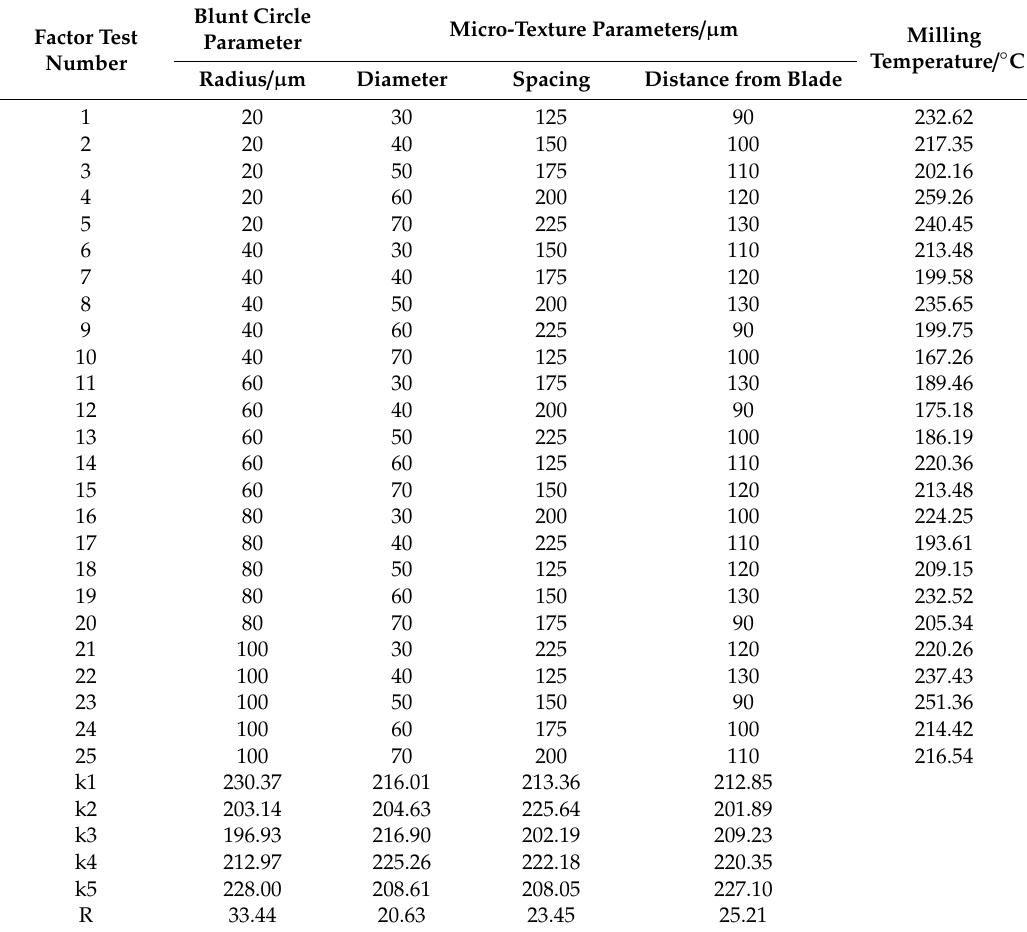
Table 5. The range analysis of milling temperature experimental